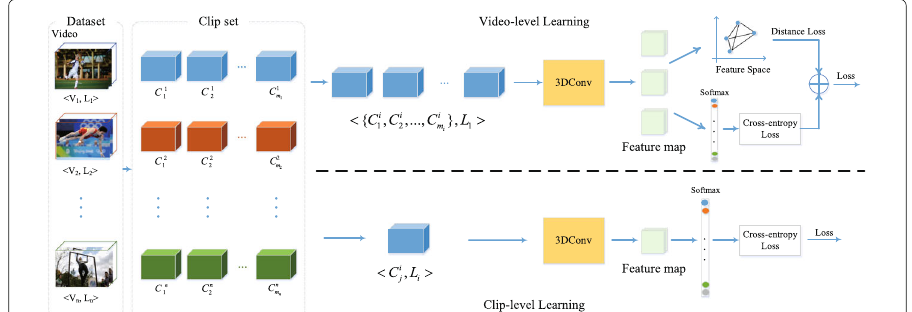
Fig. 1 Comparison of the video-level learning framework and the clip-level learning framework. V i is the i th video, and L i means action label. C i j is the j th clip in video i , and m i is the number of clip in video